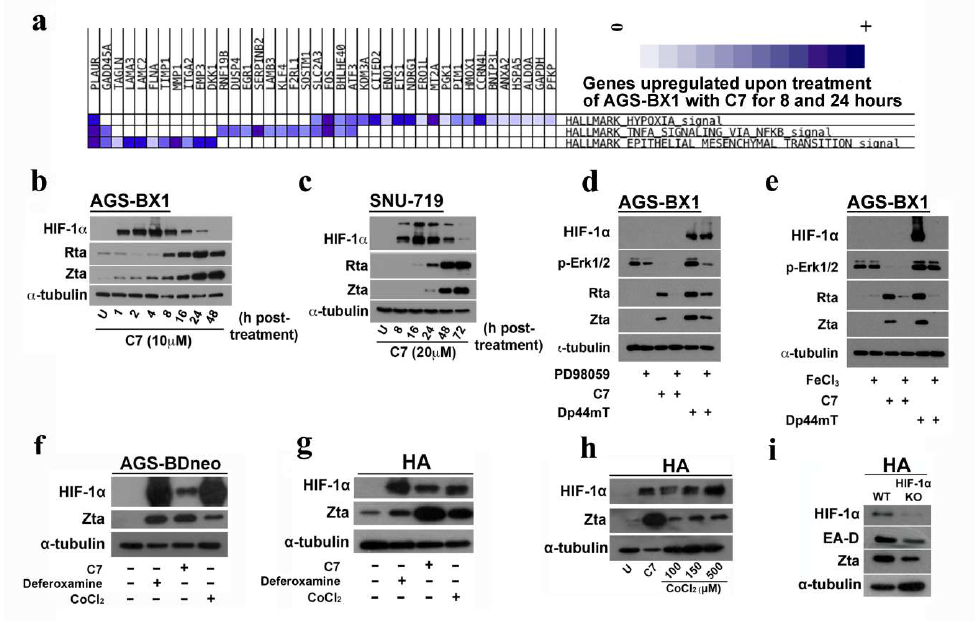
Figure 4. EBV lytic reactivation by C7 requires the activation of ERK and hypoxia signaling pathways. ( a ) Gene sets enriched with a false discovery rate (FDR) smaller than 0.05 were subject to leading edge analysis to obtain a leading edge subset of genes. Clustered map of leading edge subsets upregulated in C7_24 h treatment compared to solvent control. Degree of upregulation is shown with color intensity (darker color indicates greater fold change). ( b ) AGS-BX1 cells were incubated with 10 µ M C7 for 1, 2, 4, 8, 16, 24 and 48 h and the expression of Zta, Rta, and HIF-1 α was examined by Western blotting. ( c ) SNU-719 cells were incubated with 20 µ M C7 for 8, 16, 24, 48 and 72 h and the expression ofZta, Rta, and HIF-1 α was examined by Western blotting. ( d ) AGS-BX1 cells were pretreated with 50 µ M PD98059 (mitogen-activated protein kinase kinase (MEK) inhibitor) for 1 h, and then incubated with 10 µ M C7 or Dp44mT for 48 h. The expression of Zta, Rta, p-ERK1/2, and HIF-1 α was analyzed